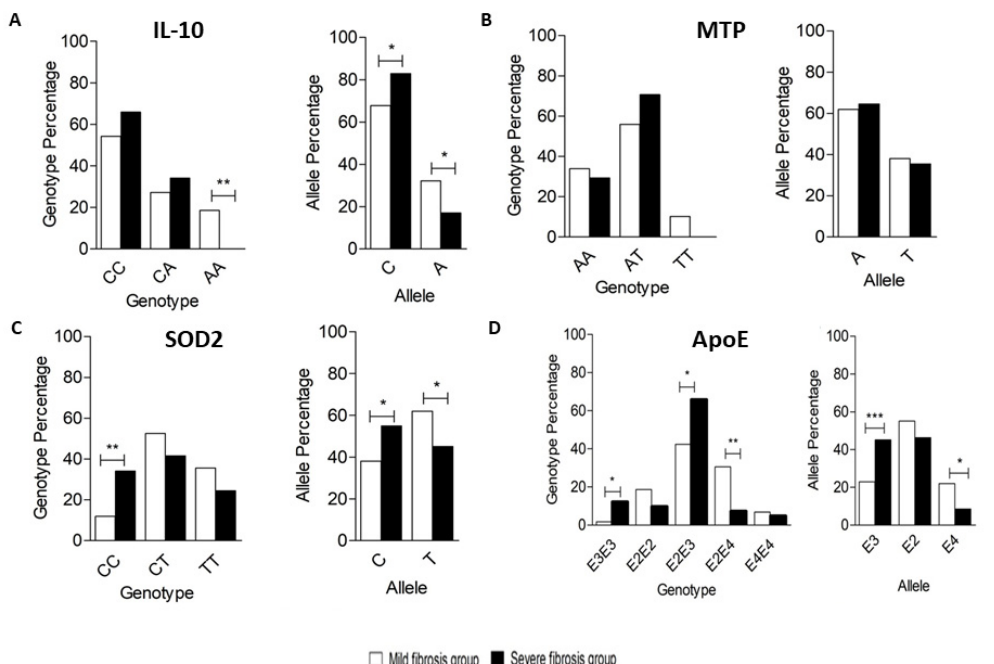
Figure 2. Genotyping and allele frequency of ( A ) IL10 , ( B ) MTP , ( C ) SOD2 , and ( D ) APOE in the studied groups. ( A ) Genotypes for the -627 IL10 polymorphisms in the Mild and Severe groups showing the frequency of distribution of each genotype in both groups by percentage (left panel); Alleles for the -627 IL10 polymorphisms in the Mild and Severe groups showing the frequency of distribution of each allele in both groups by percentage (right panel). ( B ) Genotypes for the -400 MTP (left panel); Alleles for the -400 MTP (right panel). ( C ) Genotypes for the 1183 SOD2 (left panel); Alleles for the 1183 SOD2 (right panel). ( D ) Genotypes for APOE (left panel), Alleles for APOE (right panel). * p < 0.05, ** p < 0.01, and *** p < 0.001.